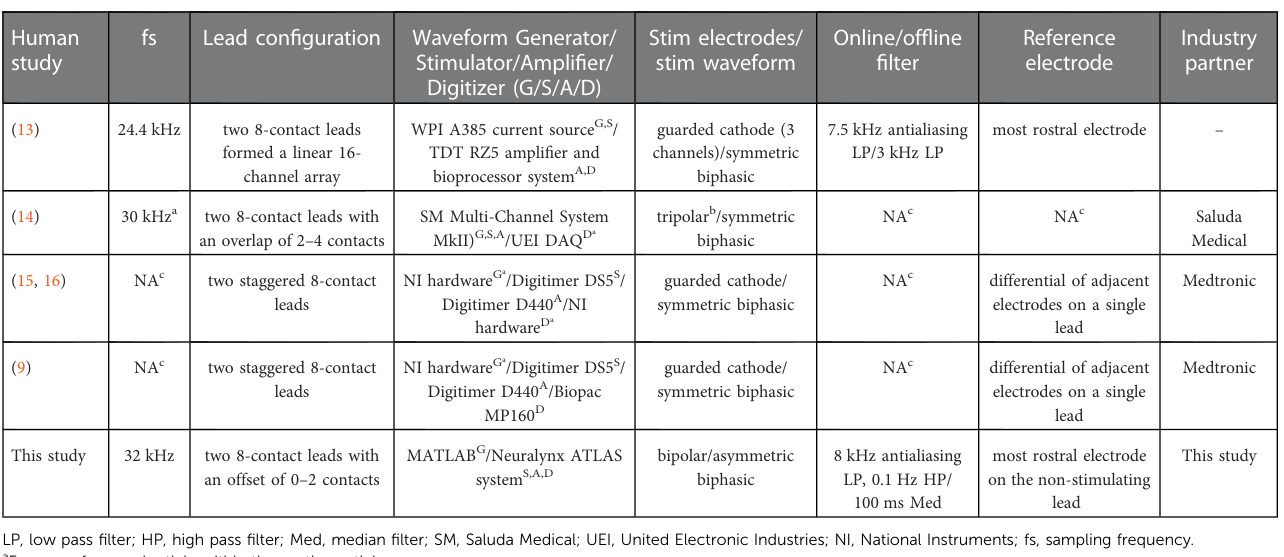
TABLE 1 A summary of the devices and settings used to record ECAPS in the human spine.